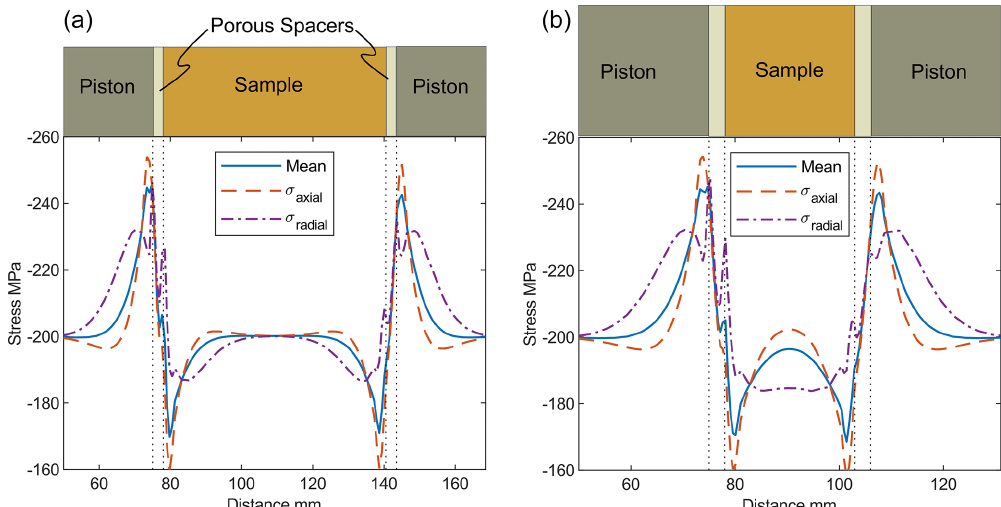
Figure 2. Results of finite-element analyses showing stress profiles of mean stress, axial normal stress, and radial normal stress along the axes of samples with a length:diameter ratios (a) 2 . 5 : 1 and (b) 1 : 1, each with a diameter of 25.4mm. At the top of each figure is a scaled schematic of the assembly; note the aspect ratio of the sample in each case. Externally applied hydrostatic stress was 200MPa. For the longer sample the stress state in the greater part of the sample was near homogeneous, but for the shorter one a differential stress on the order of 7% of the applied hydrostatic stress was induced.